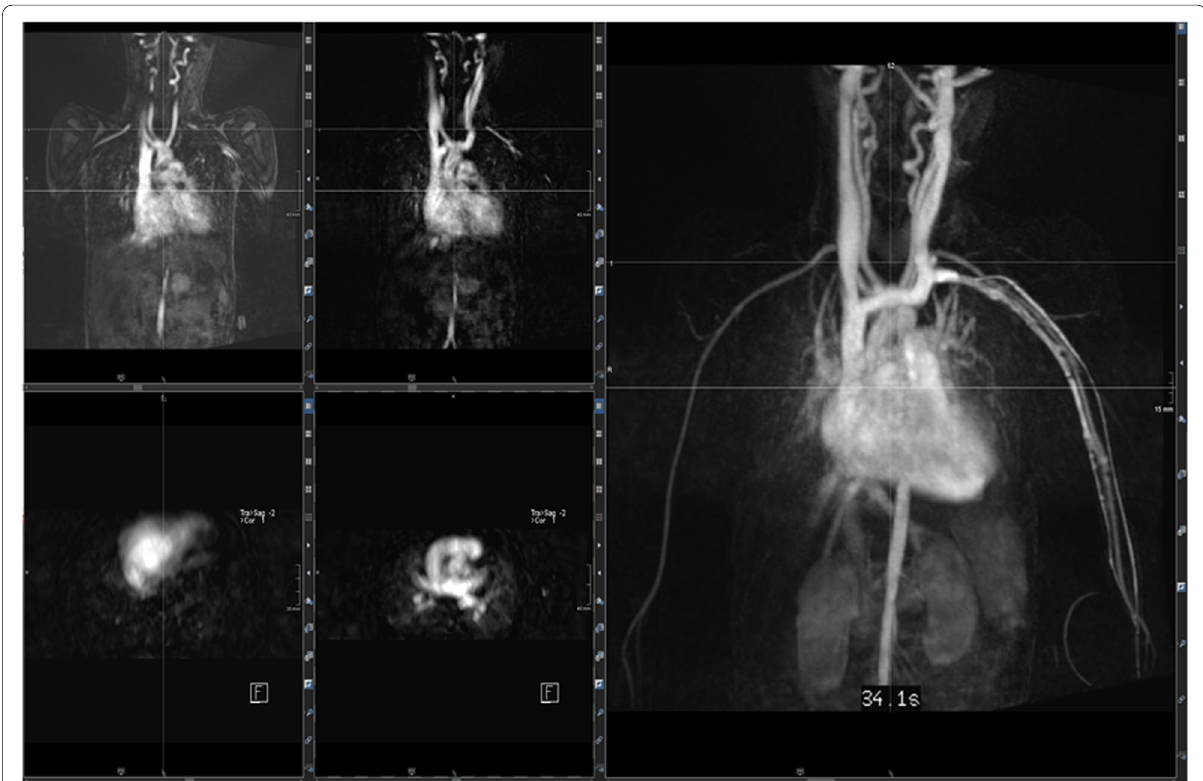
Fig. 9 (MRA): time-resolved contrast-enhanced MRA in coronal and transversal reconstructions (MIP projections) allow a complete overview of the anatomy of large vessels and the monitoring of shunting (left-right;